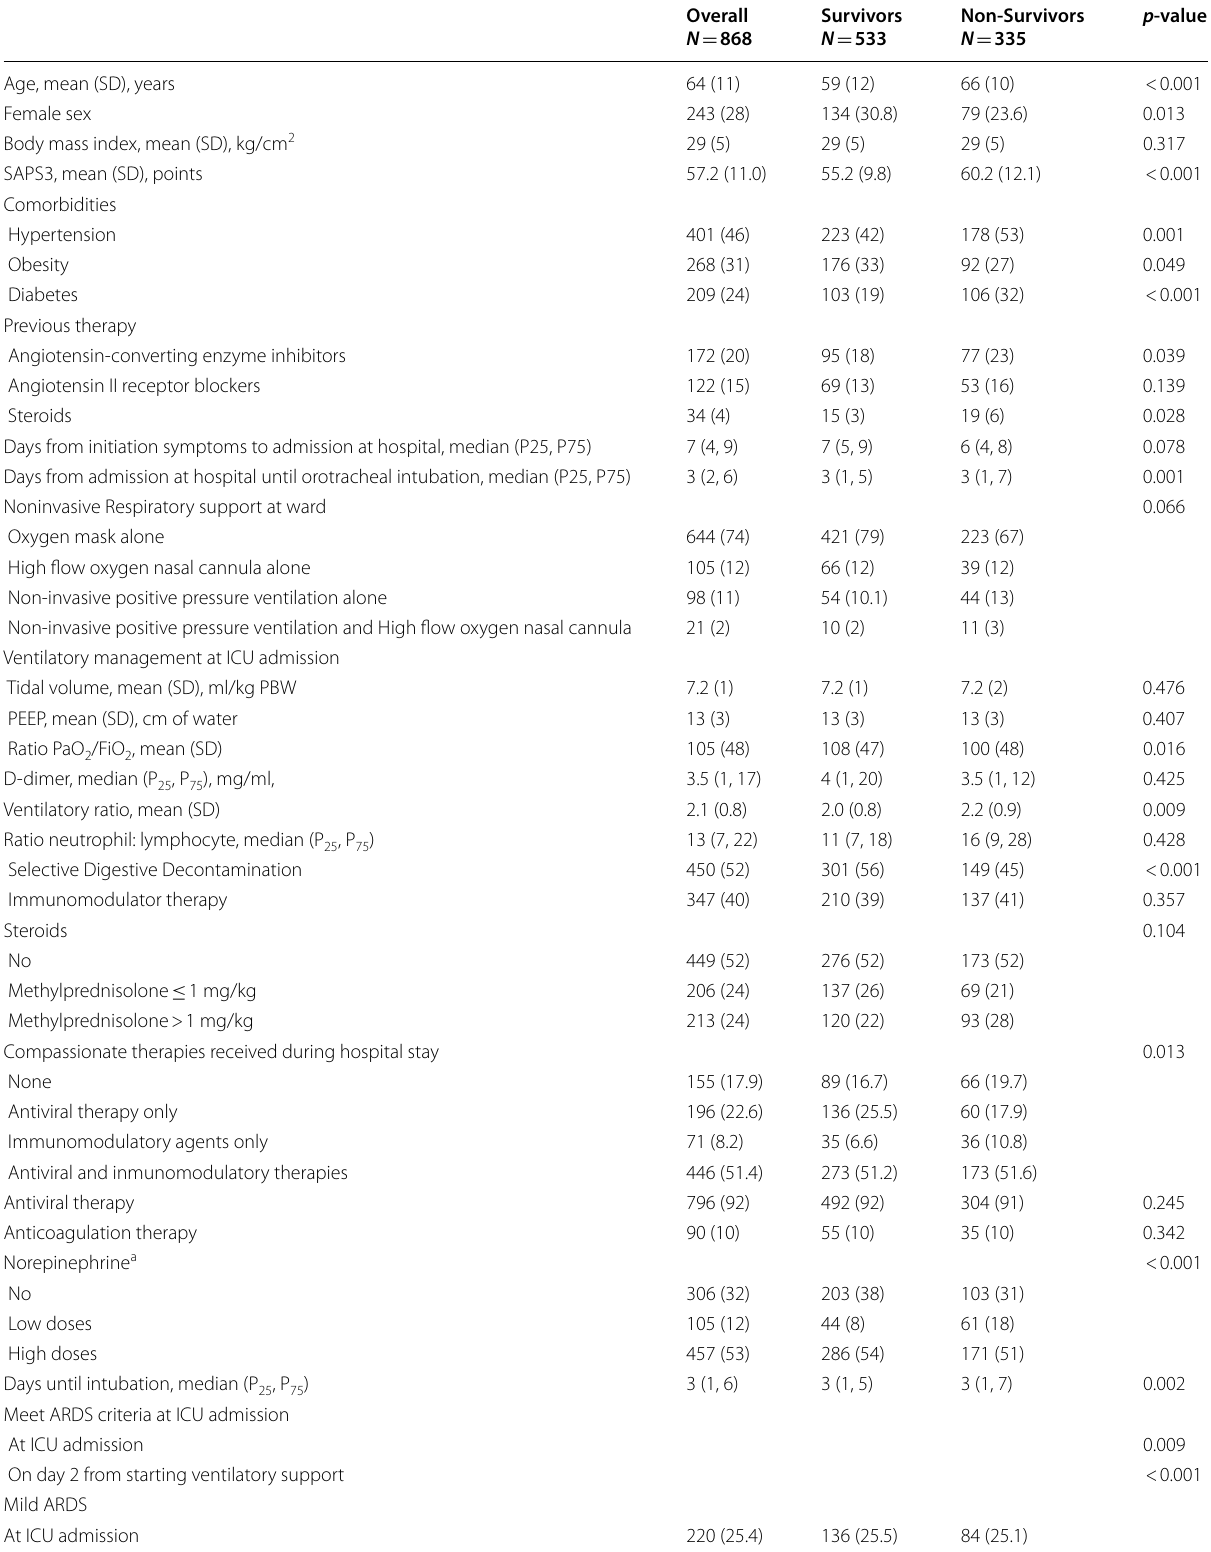
Table 1 Baseline characteristics of included patients in the